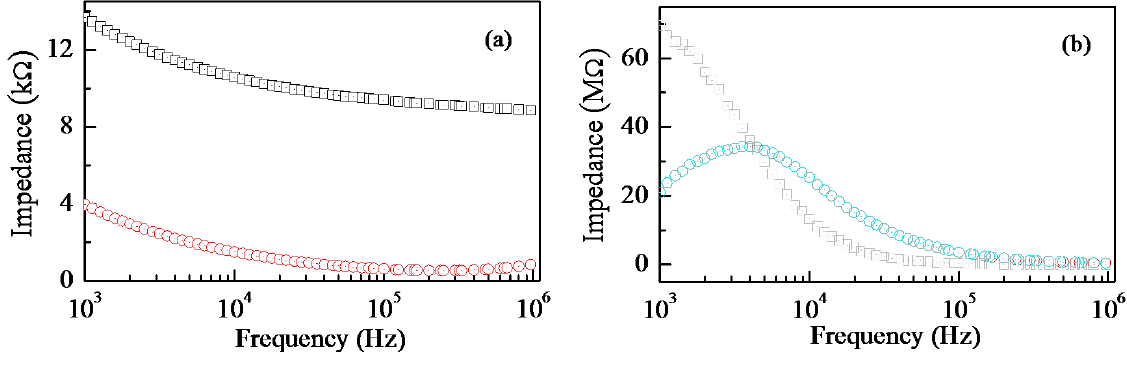
Figure 3. ( a ) Frequency dependence of the real part (black squares) and of the opposite of the imaginary part (red circles) of the complex impedance of a Nafion film. ( b ) Frequency dependence of the real part (black squares) and of the opposite of the imaginary part (red circles) of the complex impedance of a Nafion:Cu film.